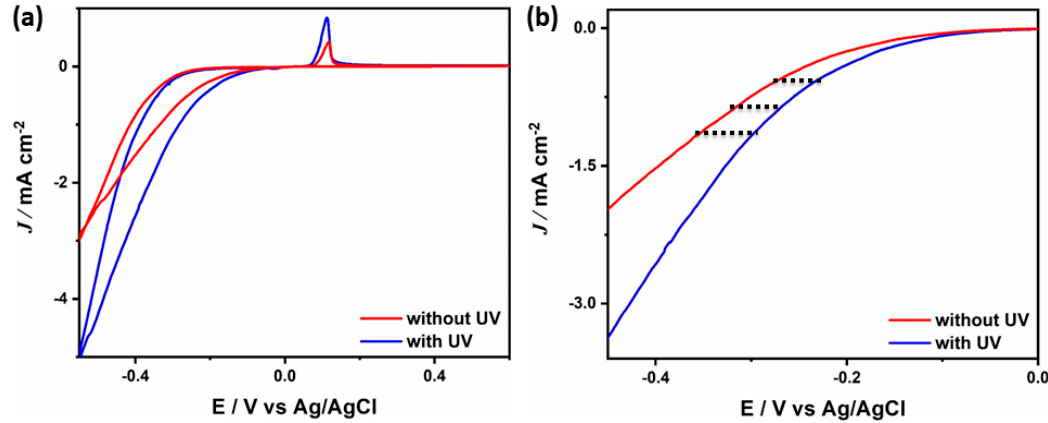
Figure 8. ( a ) CVs and ( b ) Linear sweep voltammetry measured in a solution of PBS (pH 7.4) containing 20 µ M H 2 O 2 at a scan rate of 50 mV s − 1 in the presence and in the absence of UV-light irradiation.